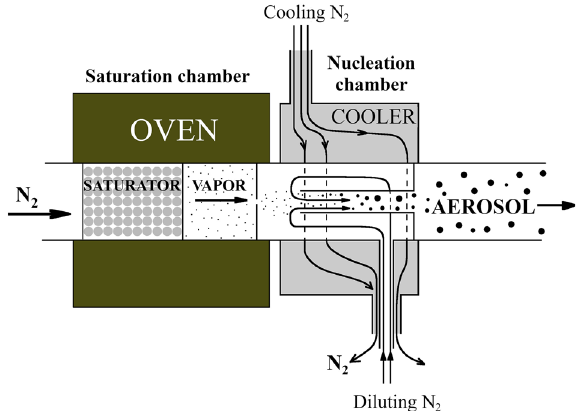
Fig. 1 Schematic of